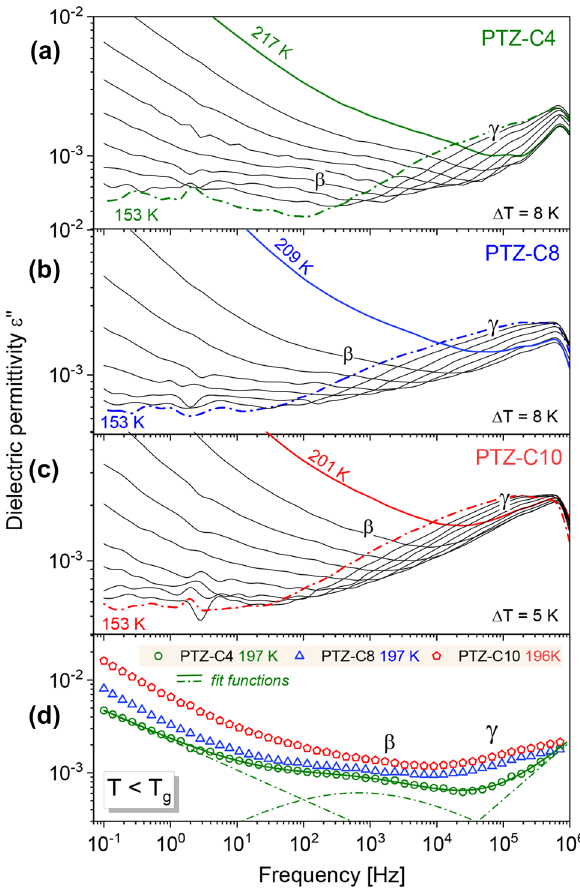
Figure 8. Representative dielectric loss spectra for PTZ derivatives collected below T g . The lowest panel shows a comparison of loss data at temperatures where τ β is comparable. The solid line is the resultant fit function for PTZ-C4 at 197 K (superposition of appropriate HN functions). The dashed lines show the individual components of the fitting